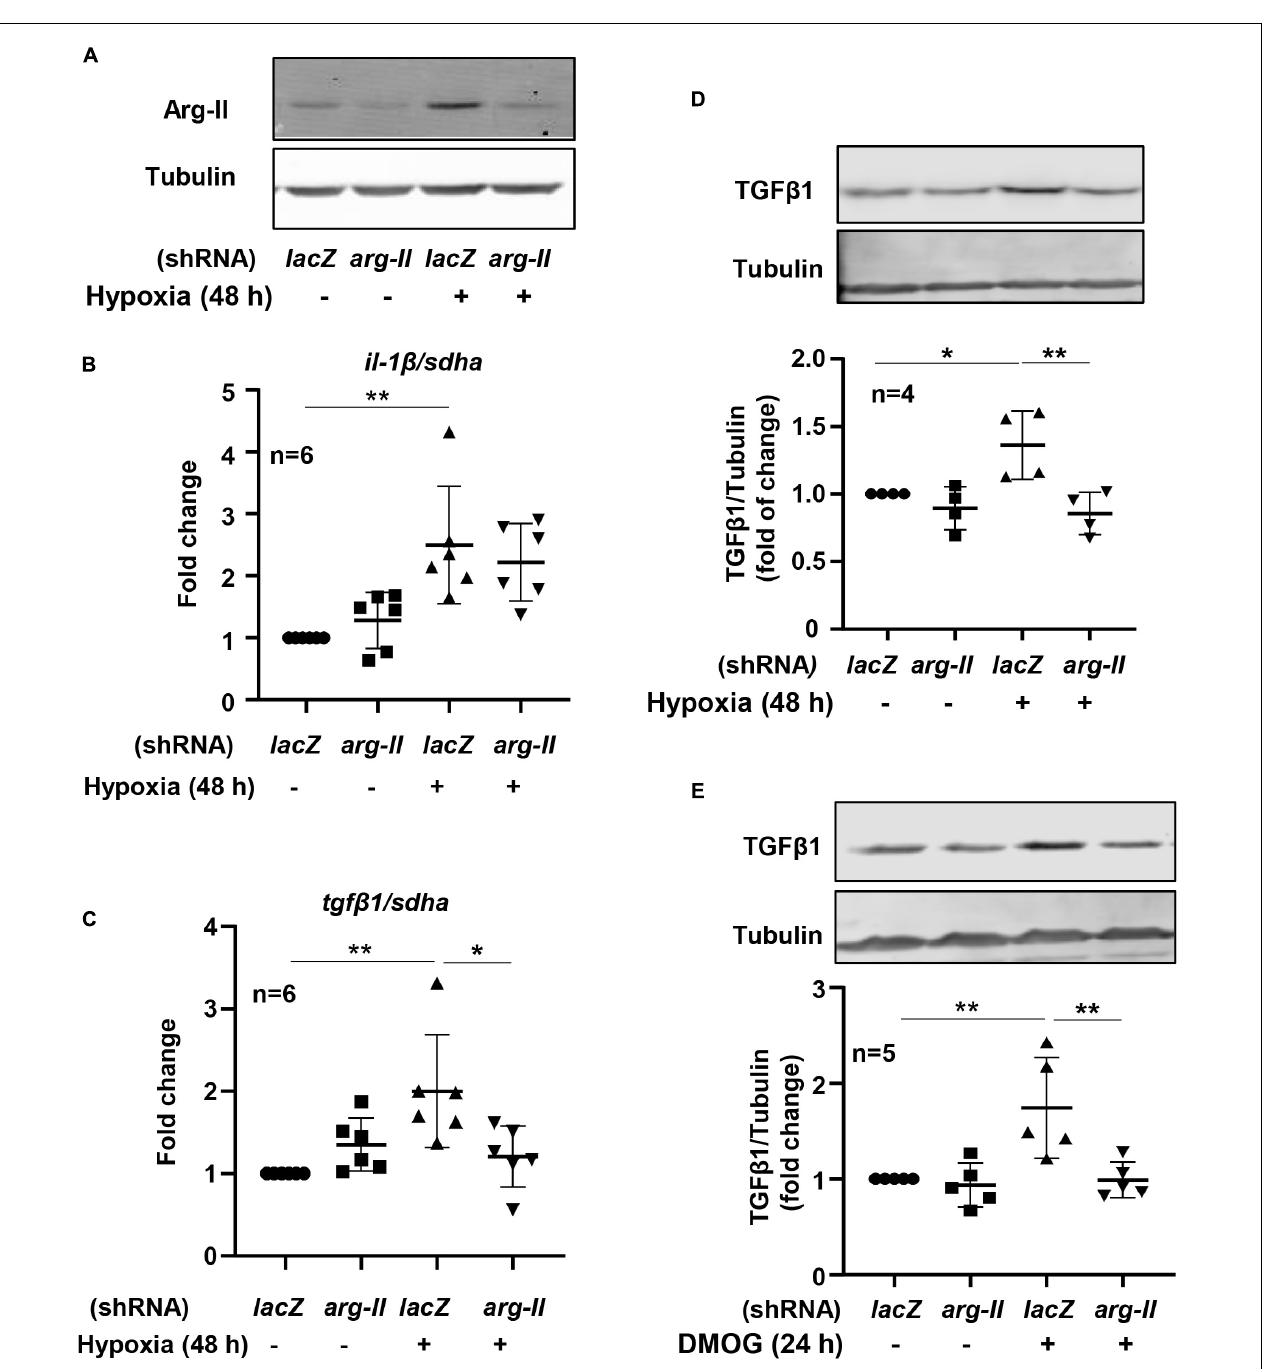
FIGURE 4 | Arg-II mediates hypoxia-induced TGF β 1 upregulation in HK-2 cells. The cells were transduced with rAd/U6- lacZ shRNA as control or rAd/U6- arg-II shRNA to silence arg-II gene, and then incubated under normoxia or hypoxia conditions for 48 h or treated with or without DMOG (1 mmol/L) for 24 h. (A) Immunoblotting shows efficiency of arg-II silencing; (B) qRT-PCR shows effects of arg-II silencing on il-1 β and (C) on tgf β 1 expression; (D) immunoblotting analysis on TGF β 1 protein levels under hypoxia conditions and (E) in cells treated with DMOG. * P < 0.05, ** P < 0.01 between the indicated groups. ANOVA with Bonferroni post hoc test was